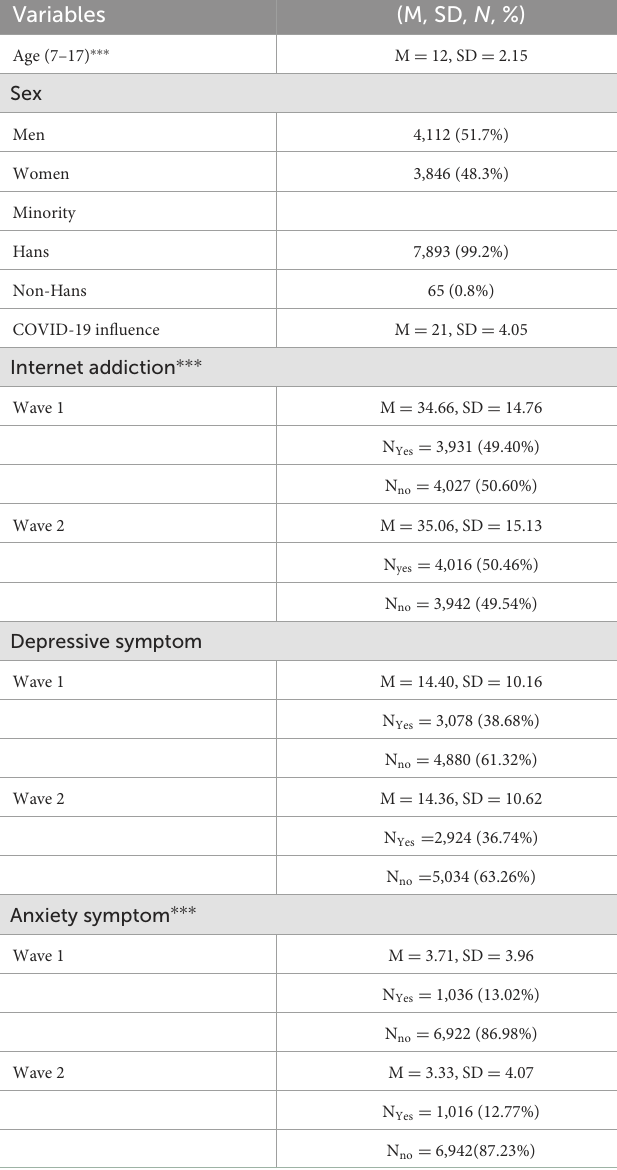
TABLE 1 Participants’ characteristics ( n =